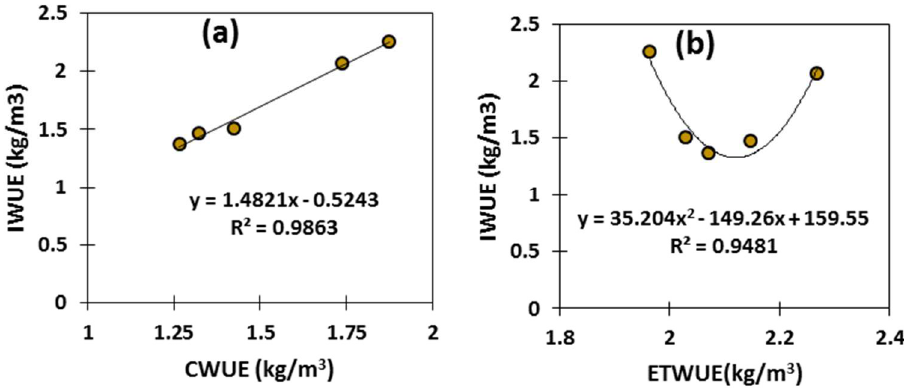
Figure 7. Relationship between ( a ) maize crop water use efficiency and irrigation water use efficiency, and ( b ) maize evapotranspiration and maize irrigation water use efficiency.